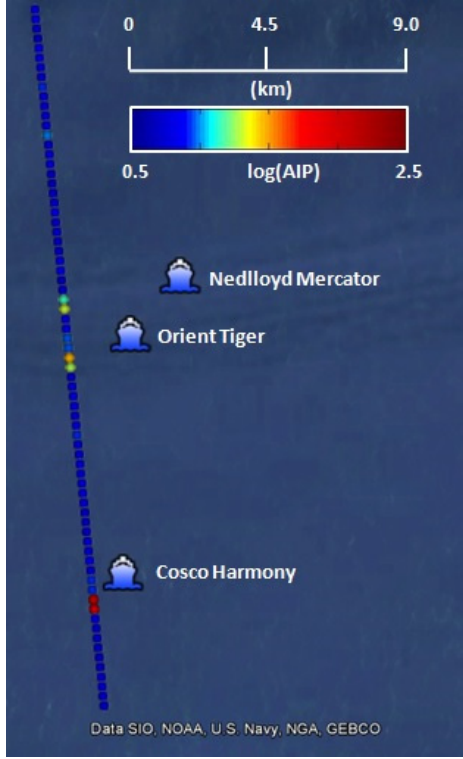
Figure 4. Projection of the AIP (in a logarithmic scale) onto the satellite track. The position of the ships is also shown.